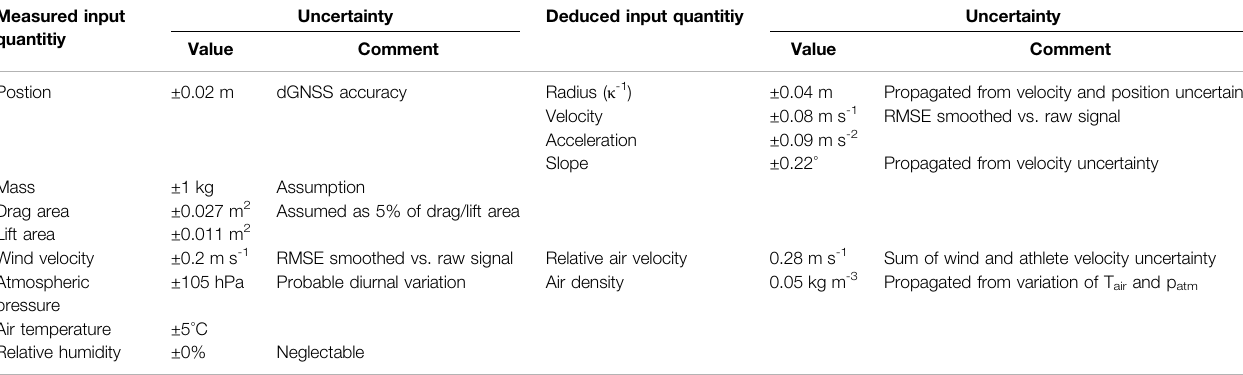
TABLE 4 | Values and explanations of the assumed uncertainties of the measured and deduced input